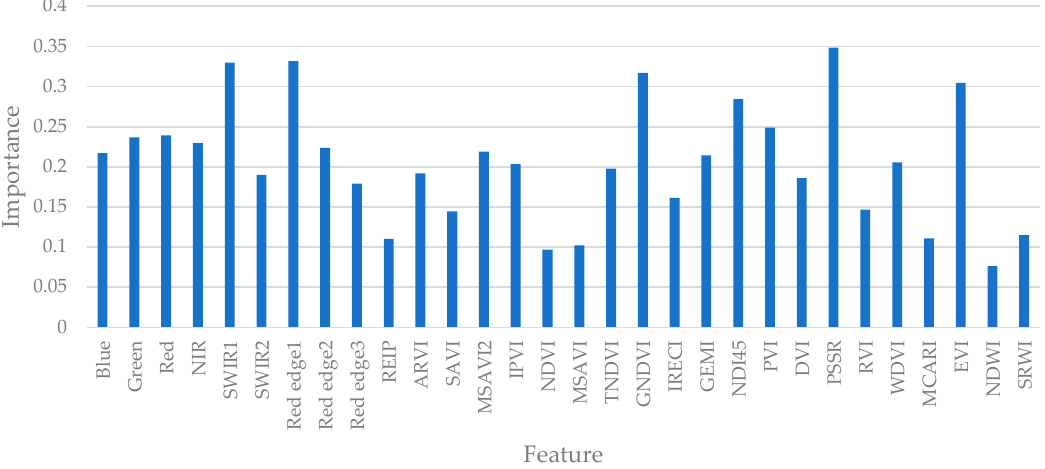
Figure 11. The importance of each vegetation indices in random forest regression (refer Table 2 for explanation of each input variables).